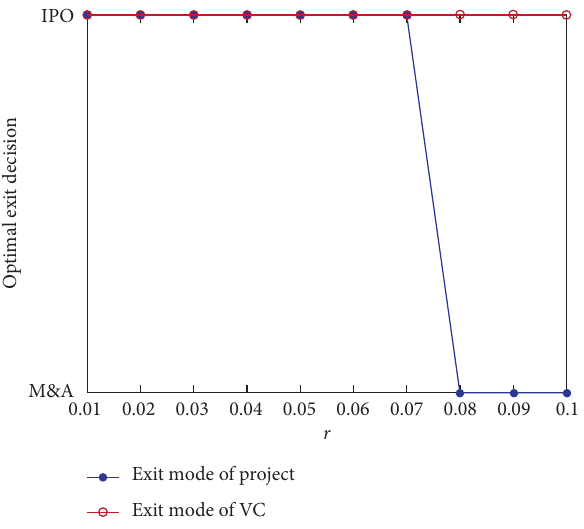
Figure 12: Optimal exit decision ( k � 7 or k � 9 ) .